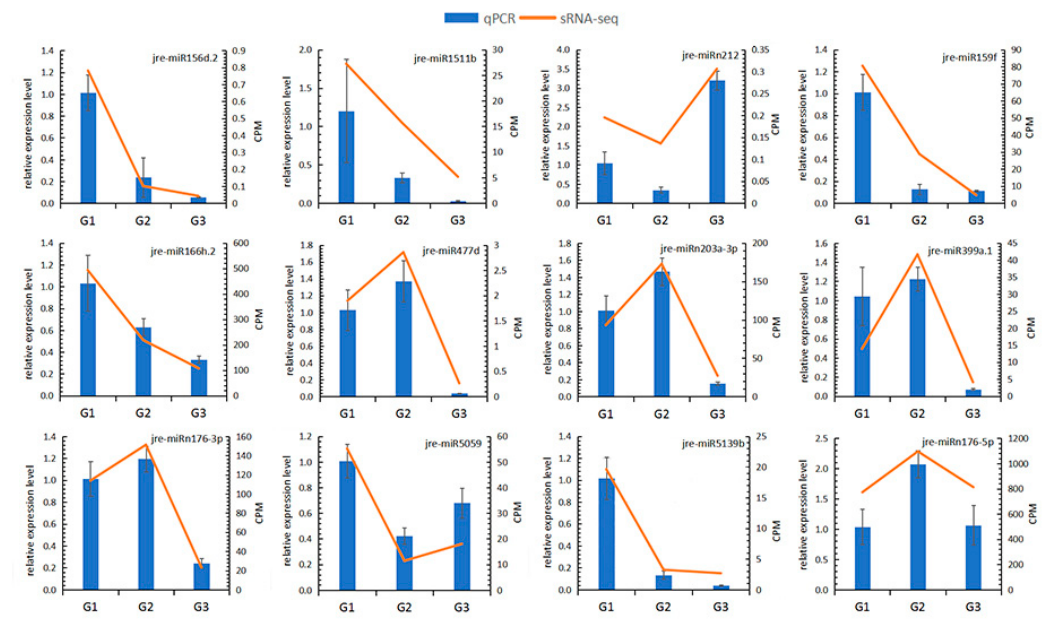
Figure 7. QRT-PCR verified the consistency of the relative expression levels of 15 random miRNAs with the small RNA sequencing results. The blue bar graph represents the relative expression level of the sample (left y -axis), and the yellow line graph represents the normalized result (CPM) of the sample in sRNA-seq (right y